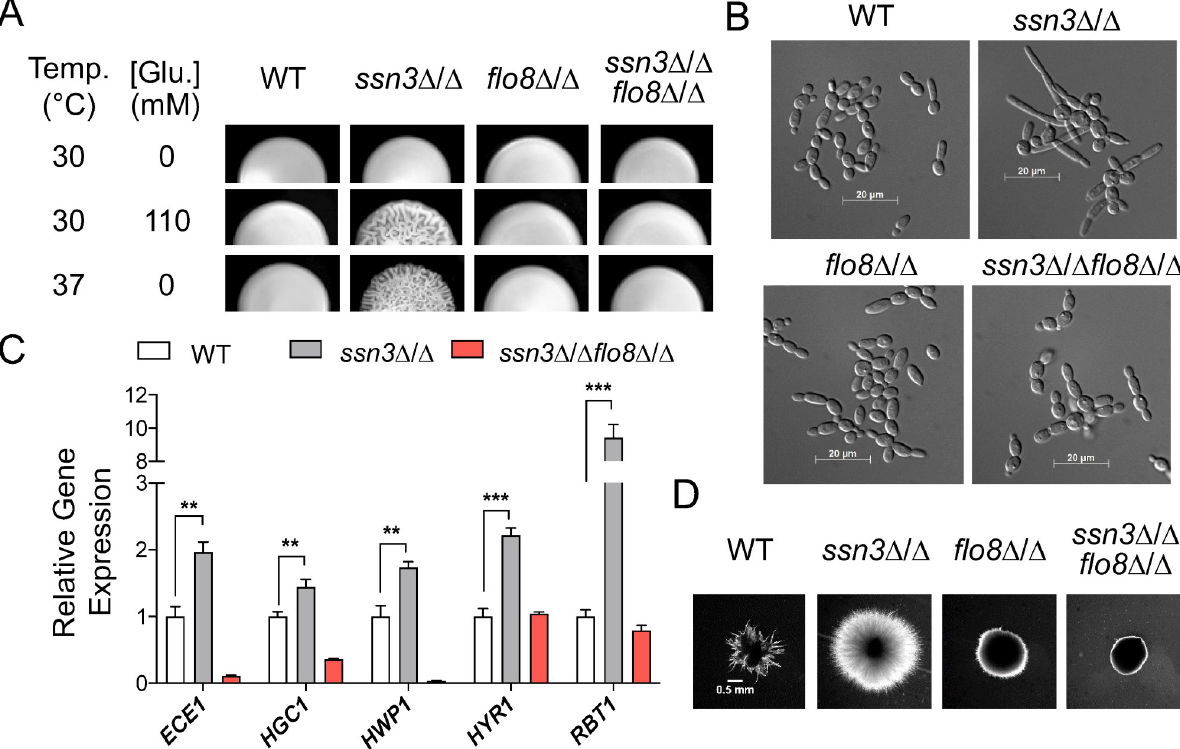
Fig 5. Ssn3 repression of filamentation is FLO8 dependent. A. Colony morphology of SC5314 wild type (WT), ssn3 Δ / Δ , flo8 Δ / Δ , and ssn3 Δ / Δ flo8 Δ / Δ strains grown on YNBA agar medium alone or supplemented with 110 mM glucose at 30˚C or on YNBA at 37˚C. B. Cell morphology of strains tested in (A) after growth in YNBN 2.5 AG (11 mM glucose) at 30˚C for 3 hours. C. NanoString analysis of indicated hypha-associated genes in WT, ssn3 Δ / Δ , and ssn3 Δ / Δ flo8 Δ / Δ .RNA was extracted from cells grown as indicated for (B) but for 75 minutes. Expression levels was represented by mean and standard deviation after normalization to TEF1 and ACT1 reference transcripts. Expression of each gene was normalized to levels for the WT. Significant differences from WT are indicated as �� , p < 0.01 and ��� ,p < 0.001. D. Embedded colonies of the same set of strains shown in (A) grown in YPS agar at 25˚C.